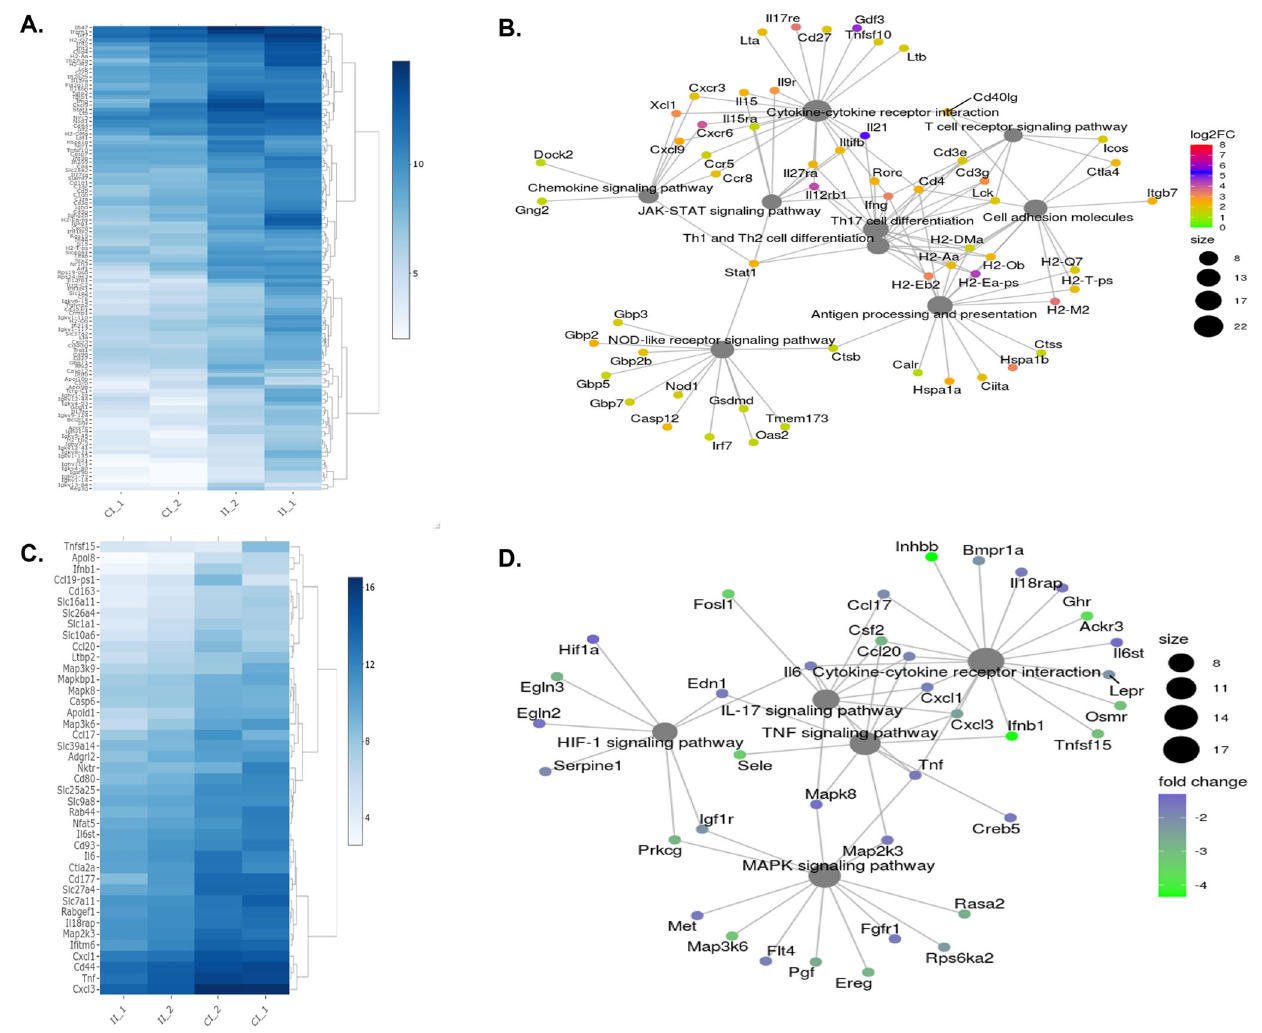
infected group_sample #2, II_1 = Lung cells from immunized or 10 μ g L-PaF BECC/ME infected group_sample #1, II_2 = Lung cells from immunized or 10 μ g L-PaF BECC/ME infected group_sample #2. Upregulated genes in immunized or 10 μ g L-PaF BECC/ME mice are shown in ( A ), downregulated genes in immunized or 10 μ g L-PaF BECC/ME mice are shown in ( C ). B Pathways upregulated in infected 10 μ g L-PaF BECC/ ME (or downregulated in infected PBS vaccinated) mice shown via a cnet plot. Upregulated genes were found in cytokine-cytokine interaction, TCR signaling, chemokine signaling, JAK-STAT signaling, Th17, Th1/Th2 differentiation, cell adhesion molecules, antigen processing, NLR signaling pathways. D Pathways downregulated in infected 10 μ g L-PaF BECC/ME (or upregulated in infected PBS vaccinated) mice shown via a cnet plot. Downregulated genes were found in cytokine-cytokine interaction, IL-17 signaling, TNF signaling, HIF-1 signaling and MAPK signaling pathways. Fold increase/decrease in ( B and D ), have been shown by different color according to the log2 scale shown in the fi gure. Size of the gene clusters have also been